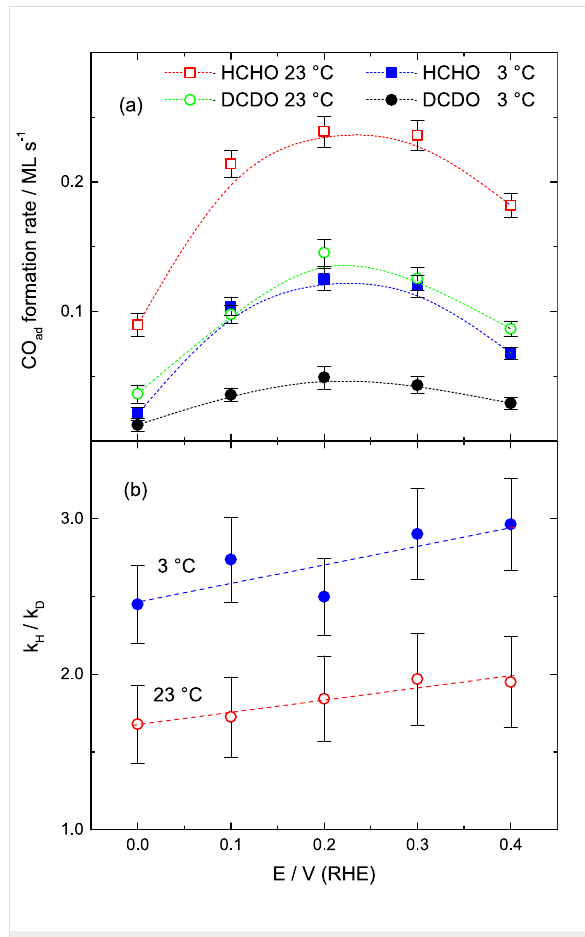
Figure 4: Initial CO ad formation rates (a) and kinetic isotope effects for the CO ad formation (b) upon admission of 0.1 M H2- or D2-formalde- hyde to a Pt film electrode in 0.5 M HClO 4 at different potentials and temperatures (see figure for notations). Lines are included to guide the